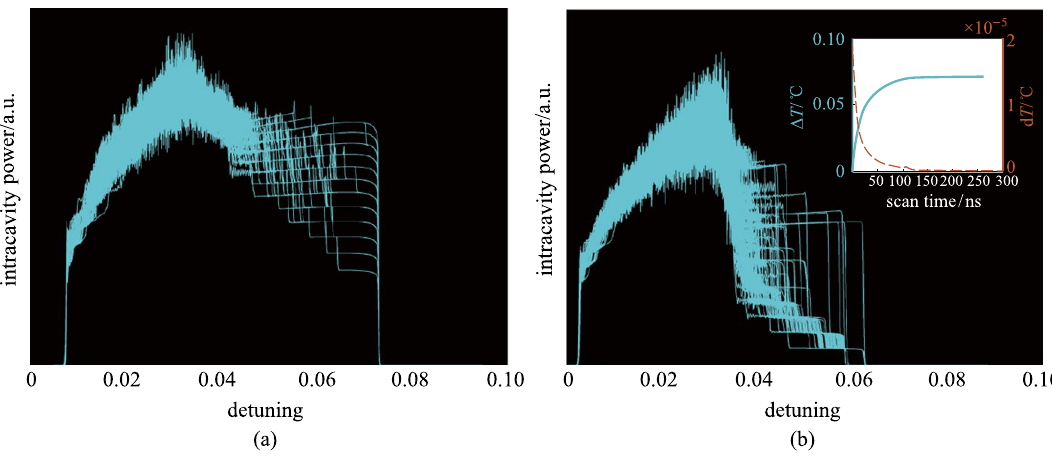
Fig. 6 Simulation results of 100 normalized intracavity power traces considering the thermal effect a without and b with the SMD effect. The inset in b gives the temperature variation in the resonator ( Δ T , the solid blue curve) and the temperature increment in every round-trip ( d T , the green dotted line). Parameters used are the same as Fig. 2. 𝛿 scans linearly starting from 0.005 at a rate of 1.5 × 10 − parameters of the silicon nitride micro-ring resonator are K = 2.78 × 10 −